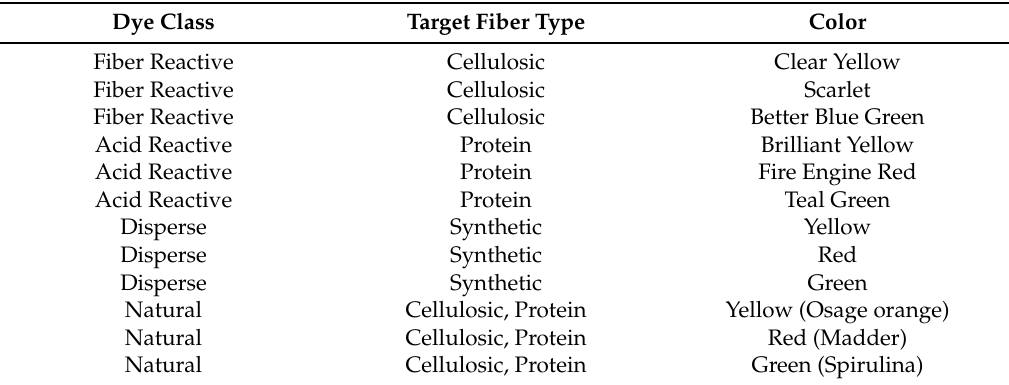
Table 3. Commercially available dyes used for